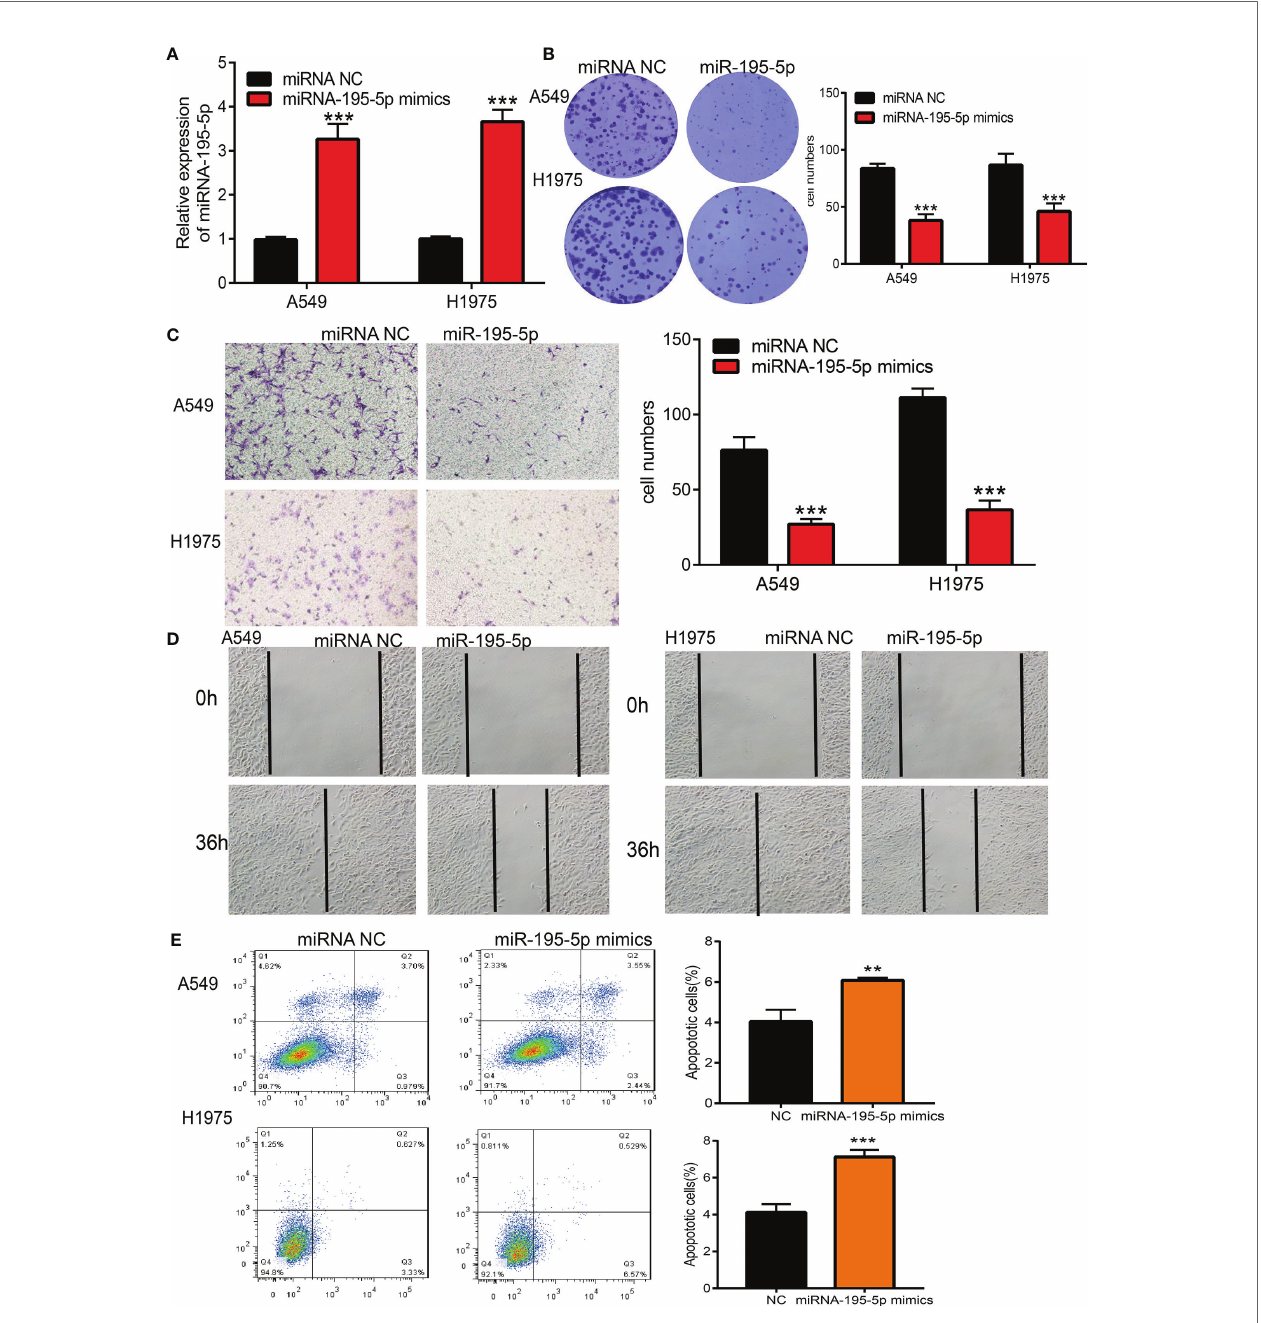
FIGURE 5 | Over-expression of miRNA-195-5p inhibits the cell proliferation and migration ability of LUAD cells. (A) The expression of miRNA-195-5p in LUAD cells lines after over-expression of miRNA-195-5p examined by using the qRT-PCR assay. (B) Over-expression of miRNA-195-5p on cell growth ability examined by clone information assay. (C) Over-expression of miRNA-195-5p on cell migration ability examined by transwell assay. (D) Over-expression of miRNA-195-5p on cell migration ability examined by wound healing assay. Quanti fi cation data were also indicated. (E) Cell apoptosis of LUAD after over expression of miR-195-5p.Scale bar=50 m m. **P<0.01;